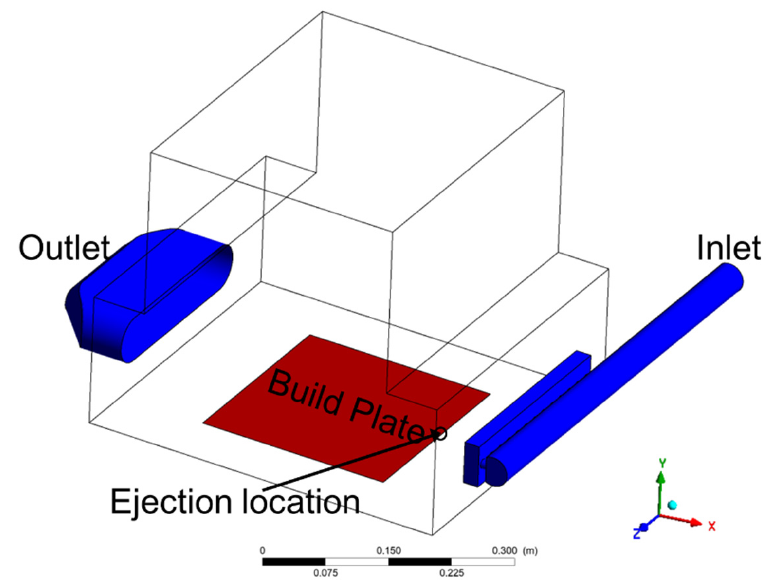
Figure 1. Schematic of the Renishaw AM250 chamber presenting the inlet, outlet, build plate, and ejection location. The build plate dimensions are 250 mm × 250 mm.